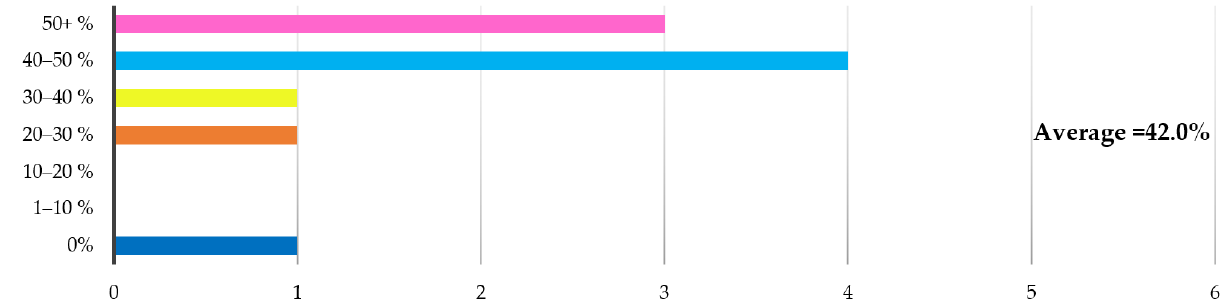
Figure 12. Responses to the question: “How much time did your design team (in the role of lead-appointed party) spend on BIM modeling activities? E.g., if the whole project was processed for a total of about 5000 h, and 1000 h were spent on BIM modeling, then 1000/5000 = 20%”.